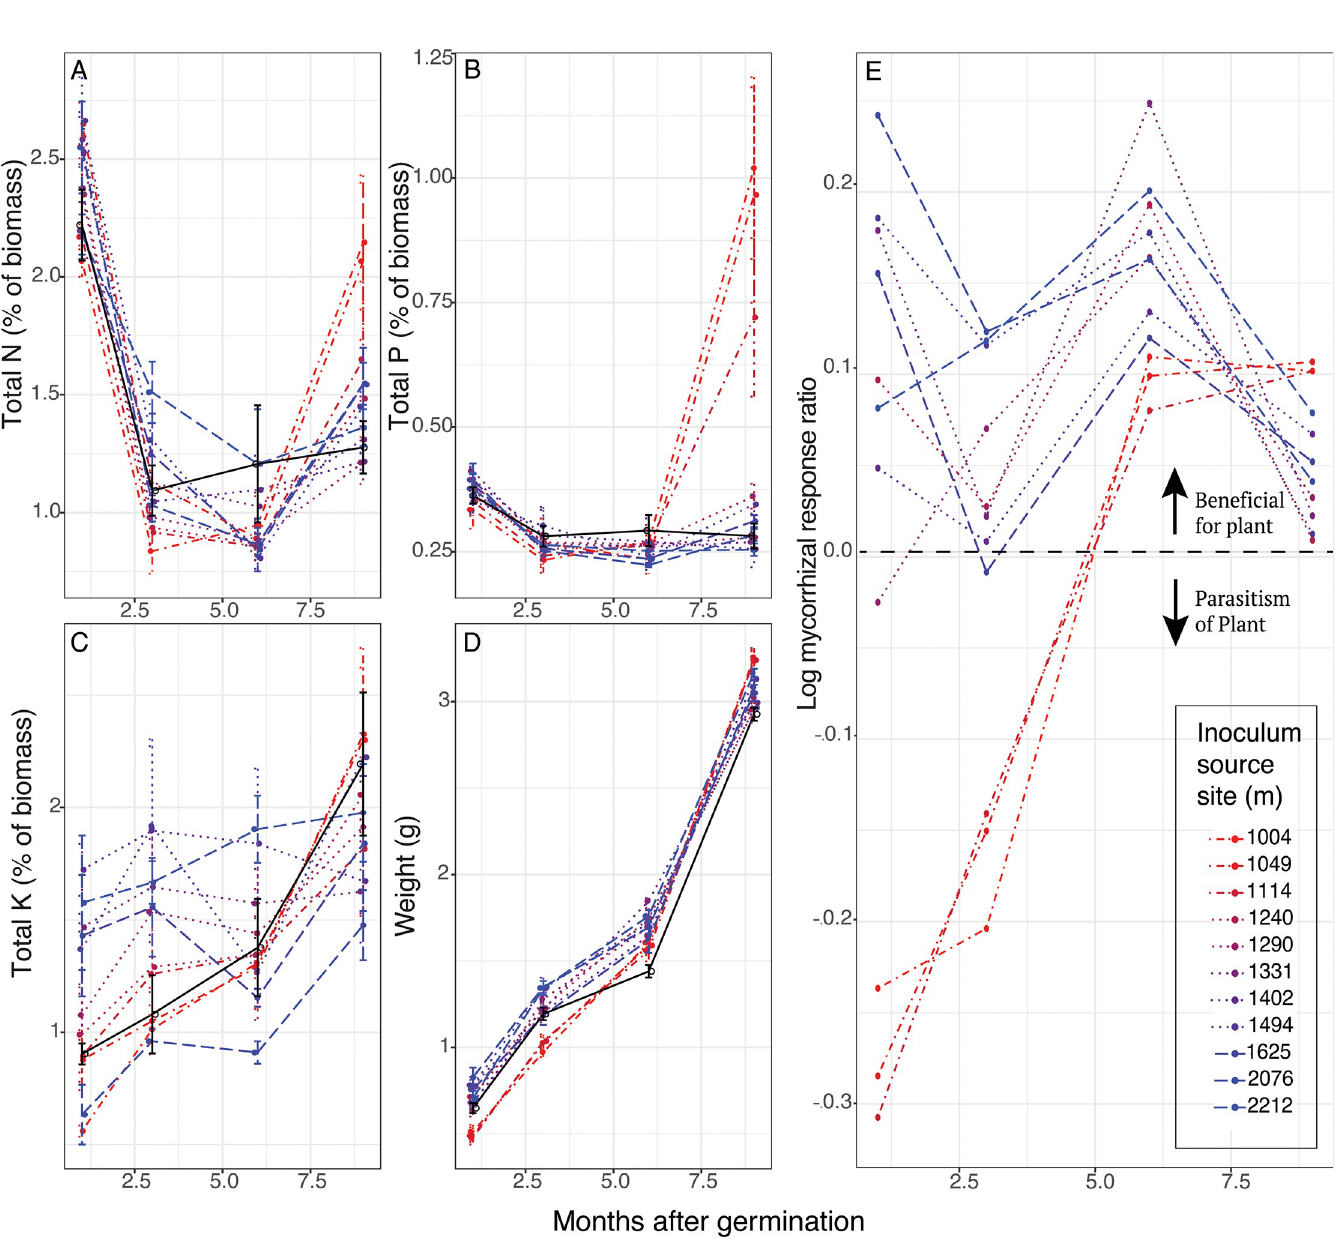
Fig 6. Responses of Joshua tree seedlings to treatment with different fungal communities. (A-D) Joshua tree seedlings inoculated with fungal communities from one of the 11 elevation sites, or as no-AMF control, and were destructively harvested at 1, 3, 6, and 9 months (averaged in triplicate). (E) Mycorrhizal growth response for Joshua tree seedlings (given as log mycorrhizal response ratio) at various monthly intervals following inoculation with whole fungal community inoculum from one of the eleven sites from across an elevation gradient. Log mycorrhizal response ratio is calculated as log (biomass treatment/biomass control). Colors correspond to AMF communities taken from field sites that range from warm to cool along an elevation gradient, or black for control, and points corresponding to nutrient analysis are jittered horizontally around value with error bars showing 1 SD. Line styles correspond to low-(dot-dash line), mid-(dotted line), and high-(dashed line) elevation fungal groups, or solid for the